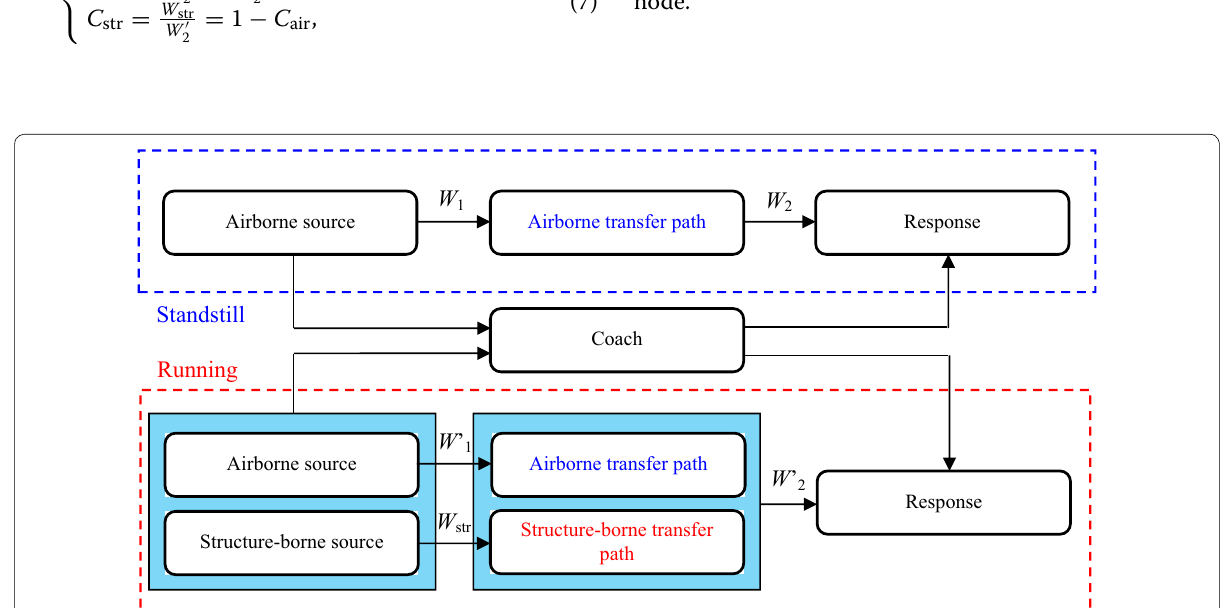
Figure 12 Method for analysing the contribution of airborne